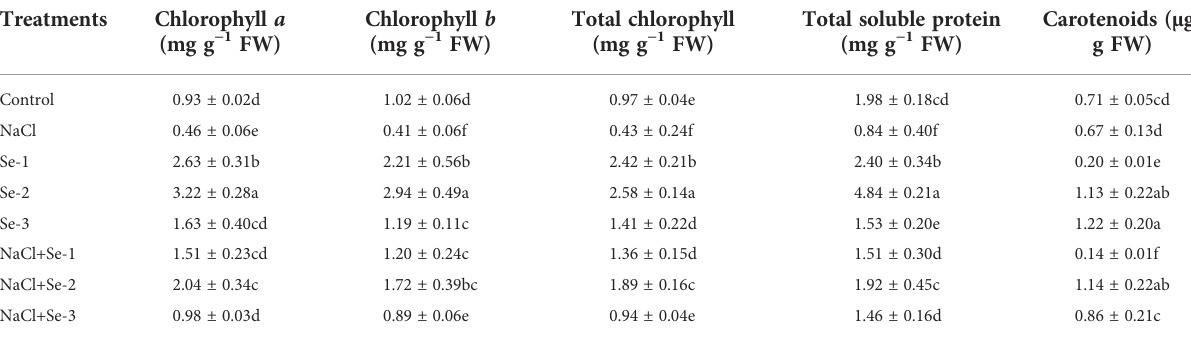
Data presented are the mean ± SD of fi ve replications. Different letters denote signi fi cant differences between treatments at p ≤ 0.05. NaCl = 200 mM NaCl; Se-1 = 75 m mo L − 1 Se; Se- 2 = 100 m mo L − 1 Se; Se-3 = 125 m mo L − 1 Se. FW, fresh weight.